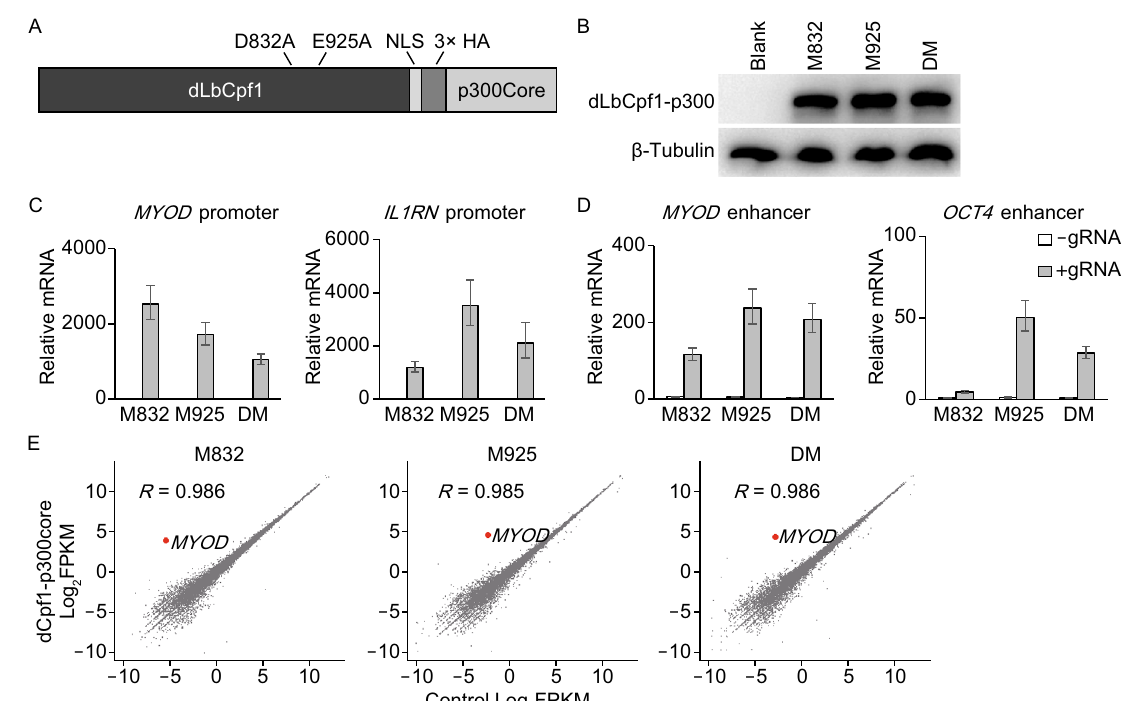
Figure 1. dLbCpf1-p300core fusion proteins activate endogenous gene expression from promoters and enhancers